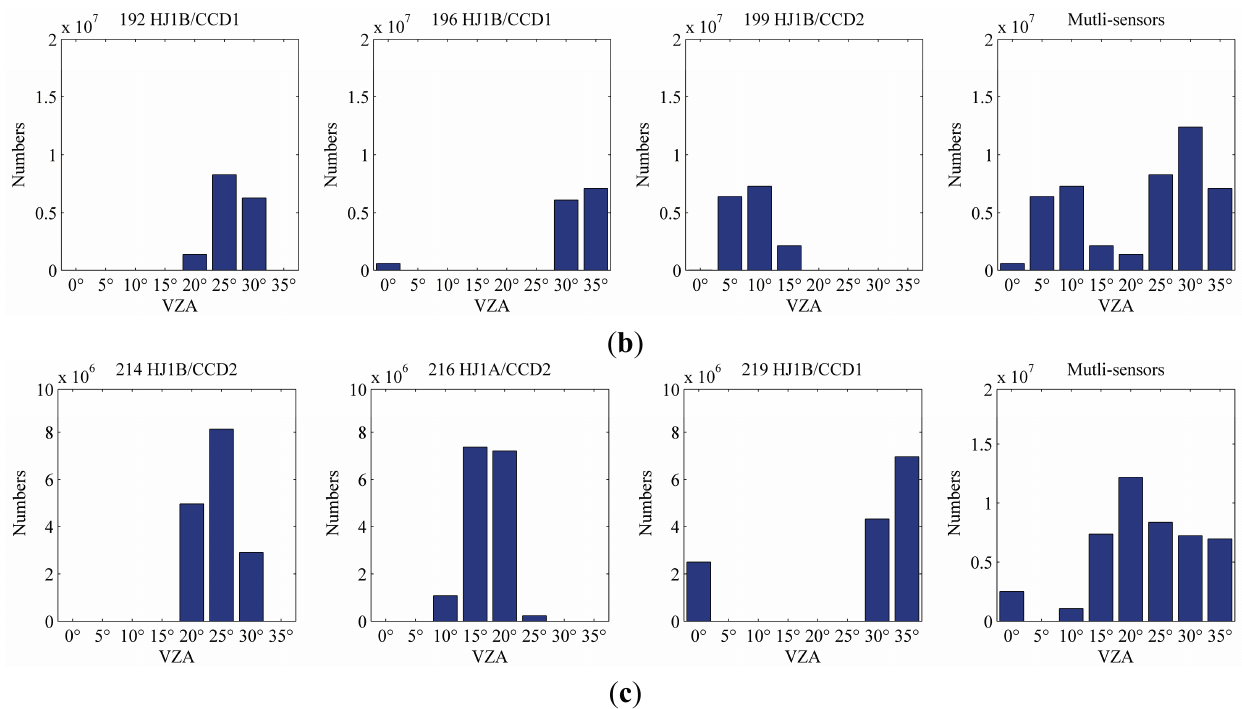
Figure 7. Distributions of the observation angles for three typical observation periods. ( a ) 1 June 2013; ( b ) 11 July 2013; and ( c ) 31 July